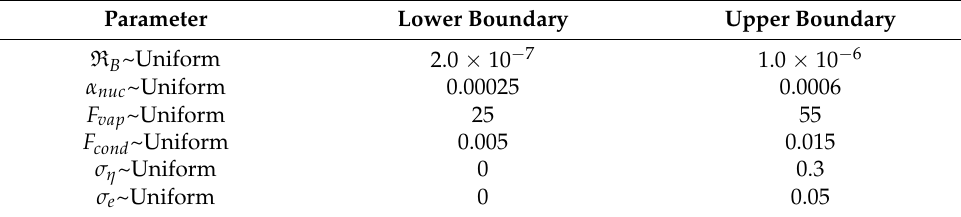
Table 8. The prior distribution interval of random